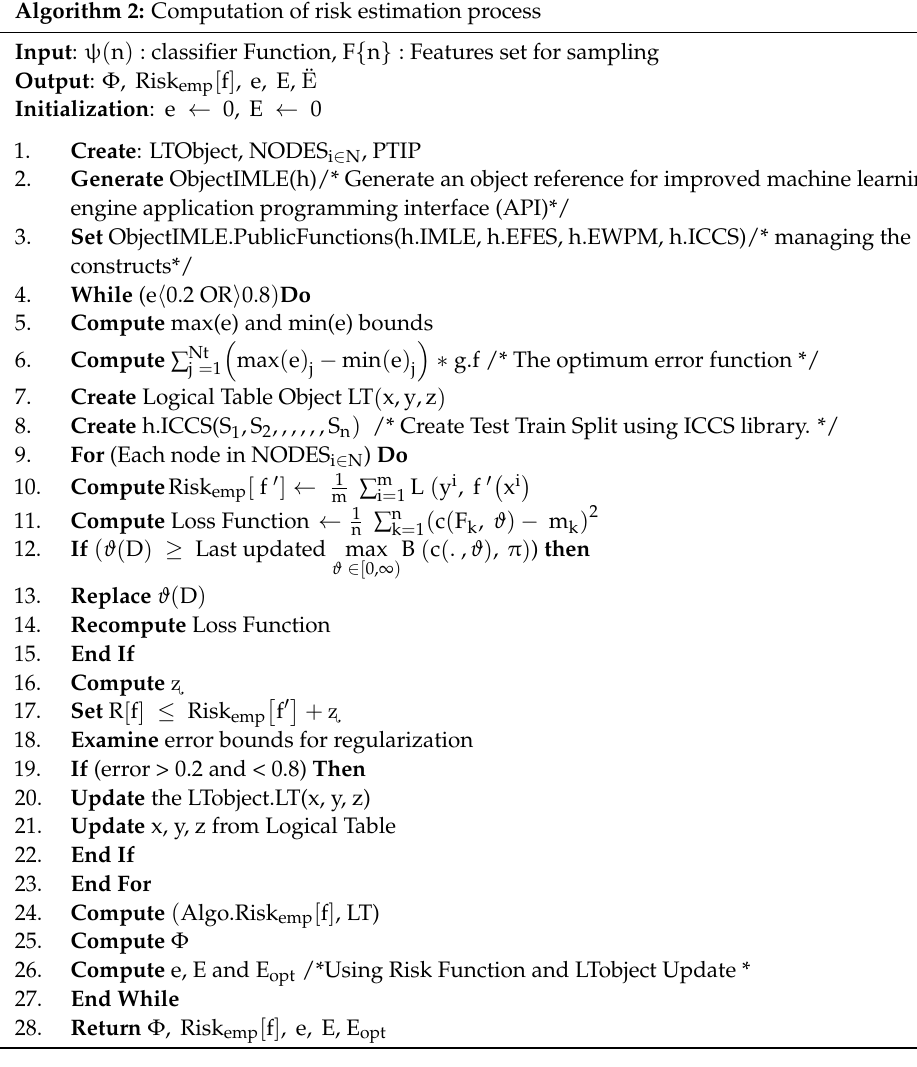
Figure 4. Illustration of risk estimation function in 3-d space for in-bound LE and GE. Algorithm 2 maximizes fitness, this algorithm computes the risk estimation function, local error bounds, and metrics evaluation. It builds on Theorem 1. It tunes the blend to stay within error bounds for ensuring optimum fitness based on the Risk Estimation Function and observed errors, and then assesses metrics to ensure the blend’s overall performance. Algorithm 2: Computation of risk estimation process